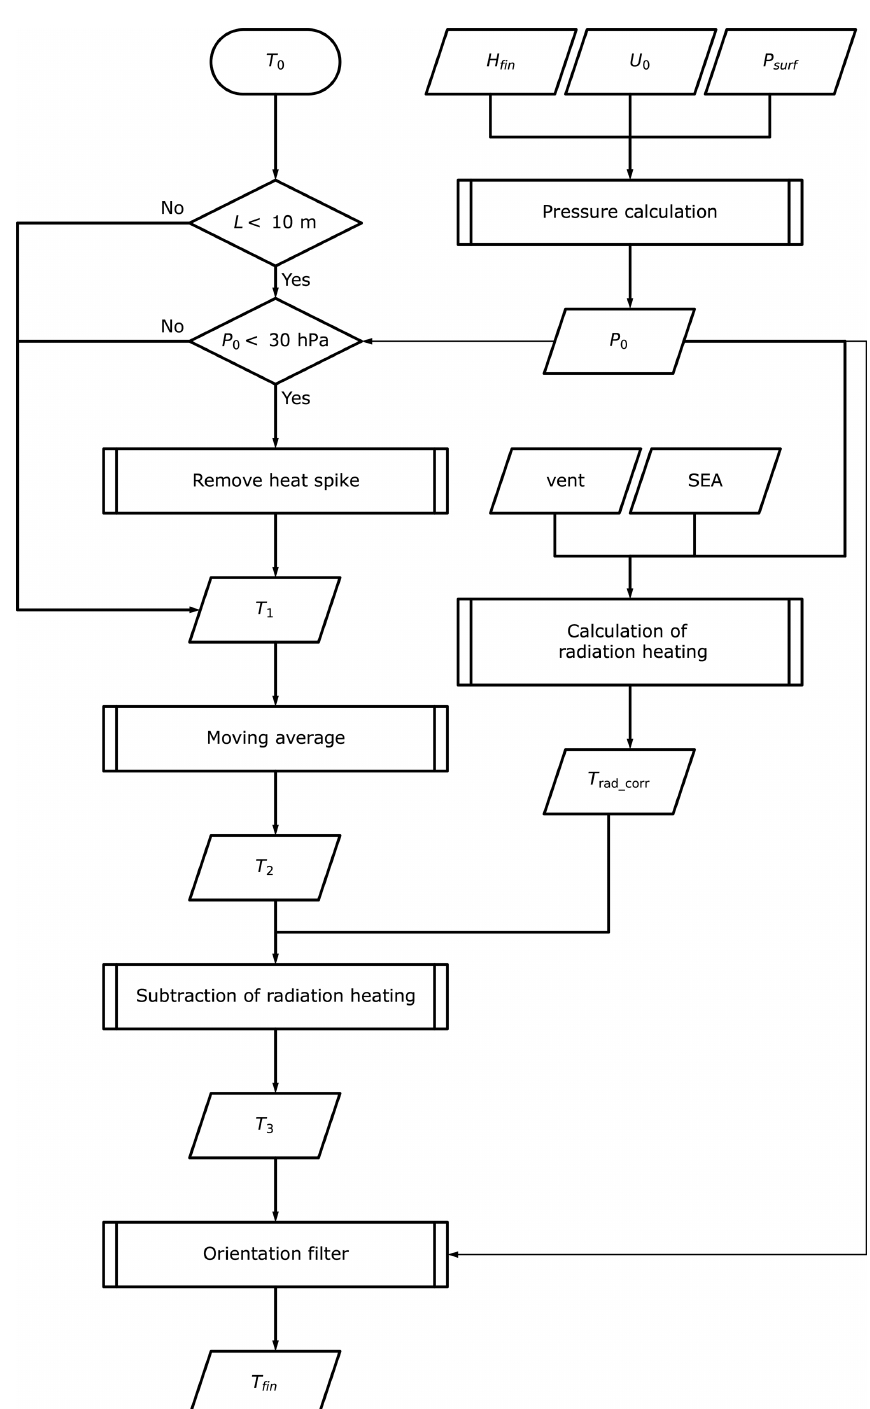
Figure 3. Temperature processing for iMS-100 ( L is the total string, or unwinder, length; SEA is the Sun elevation angle derived from time and the radiosonde position). The meanings of the shapes are same as in Fig. 2. Diamonds represent the